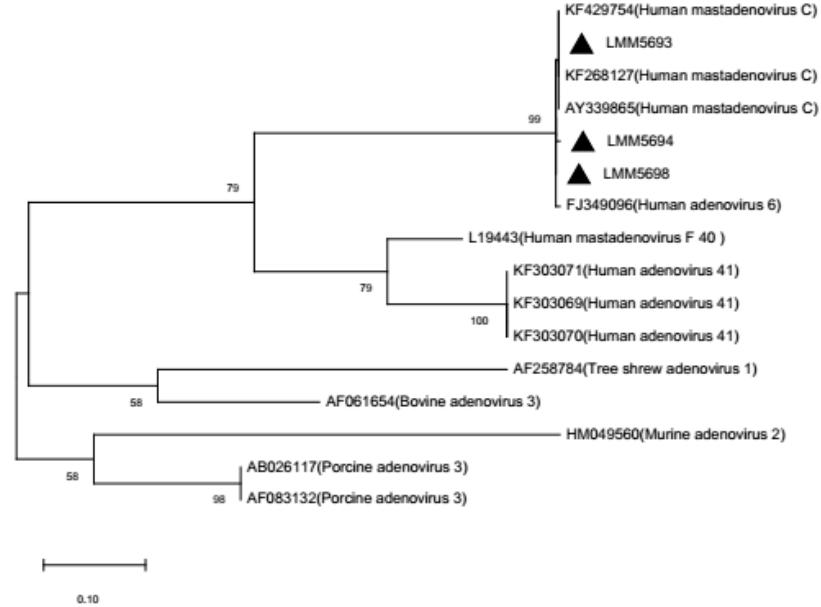
Figure 6. Phylogenetic analysis in water samples positive to HAdV using IMS as a concentration method.